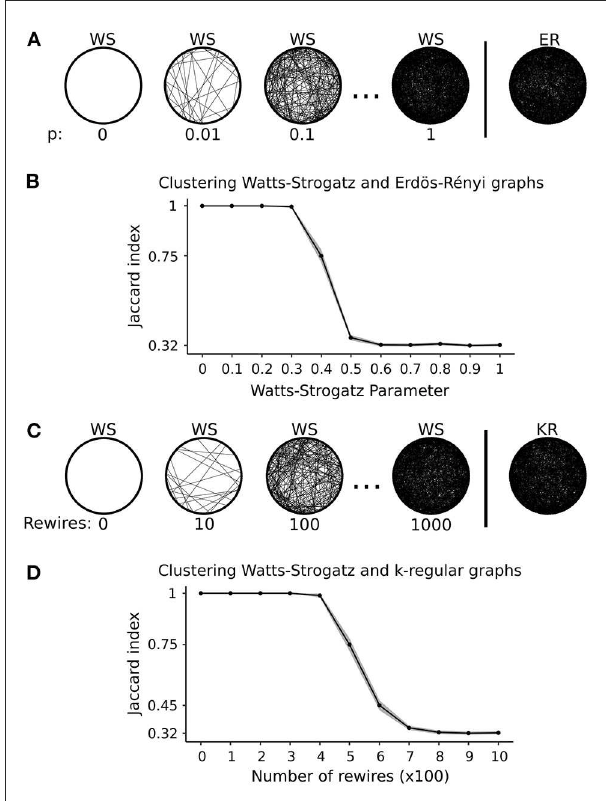
FIGURE3 Graphical representation and results of simulation 2. (A) Graphical representation of scenario (a), i.e., varying Watts-Strogatz (WS) graphs parameter until it approaches an Erdös-Rényi (ER) graph. (B) Results of scenario (a). Each point represents the average Jaccard index of 100 runs. The shaded area represents the 95% confidence interval. (C) Graphical representation of scenario (b), i.e., rewiring Watts-Strogatz (WS) graphs edges until it approaches a k-regular (KR) graph. (D) Results of scenario (b). Each point represents the average Jaccard index of 100 runs. The shaded area represents the 95% confidence interval. The Jaccard index of 0.32 corresponds to 50% accuracy for both